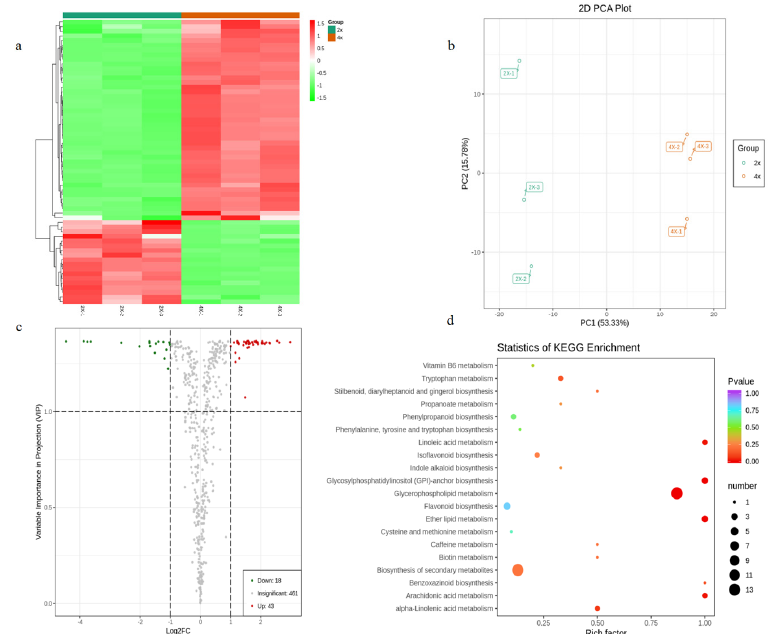
Figure 4. Multivariate analysis of identified metabolites. ( a ) Hierarchical clustering analysis of metabolites identified from diploid (2X) and tetraploid (4X) samples; ( b ) plot of the orthogonal partial least squares discriminant analysis model of metabolites identified from 2X and 4X samples; ( c ) volcano plot of 61 differential metabolites; ( d ) overview of the KEGG pathway analysis of differen- tial metabolites.